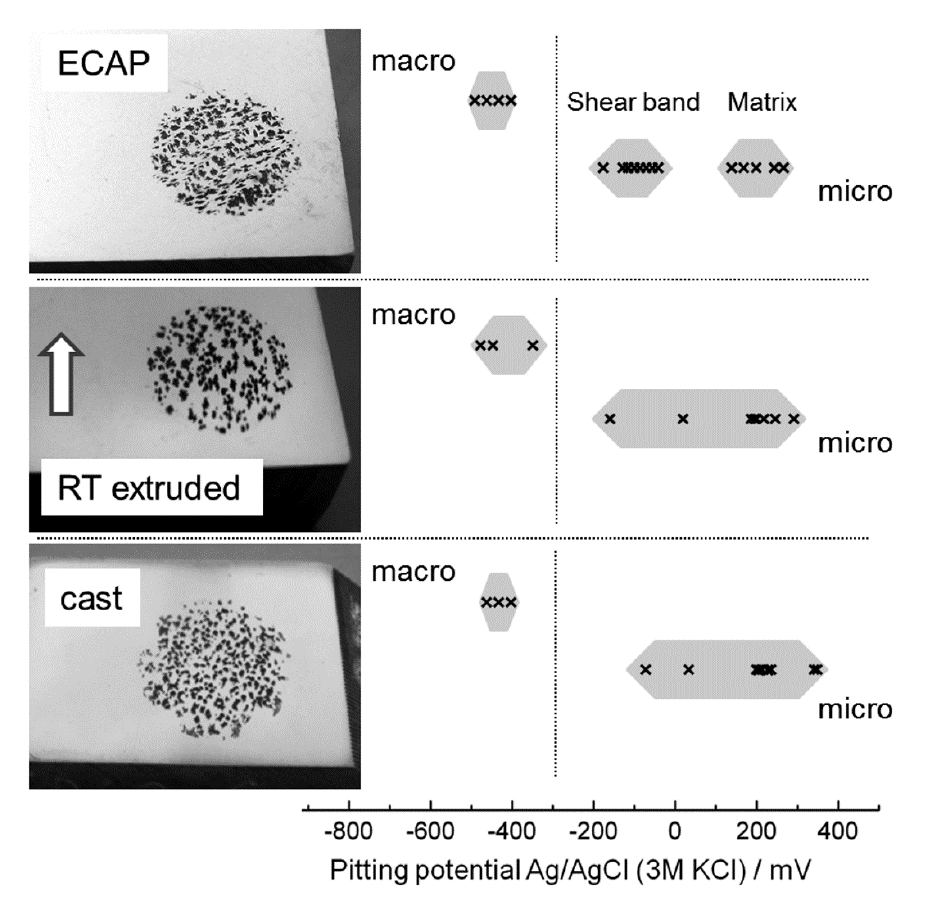
Figure 5. Documentation of the corrosion appearance after macro-scale potentiodynamic polarization of the ECAP condition, the extruded condition (extrusion direction marked by arrow) and the cast condition showing the modification from uniform to oriented (left from top to bottom) with corresponding pitting potentials in 0.1 M NaCl determined by macro-scale tests (middle) and micro-scale tests (right) at 1 mA cm −2